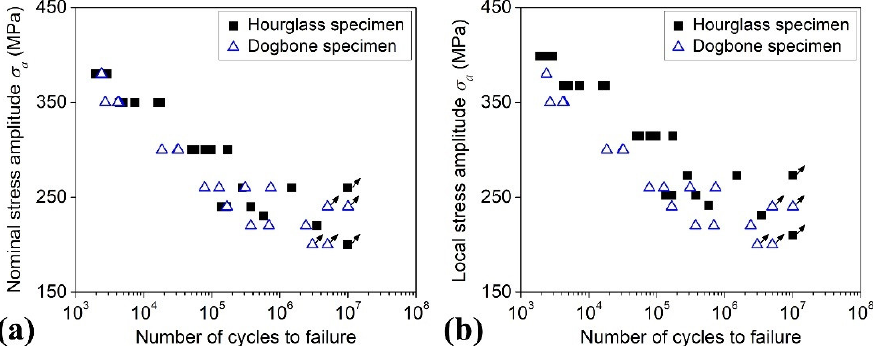
Figure 9. S-N data of specimens with different size and shape, in which the arrows denote the unbroken specimens at the associated cycles. ( a ) Nominal stress amplitude versus fatigue life; ( b ) local stress amplitude versus fatigue life.